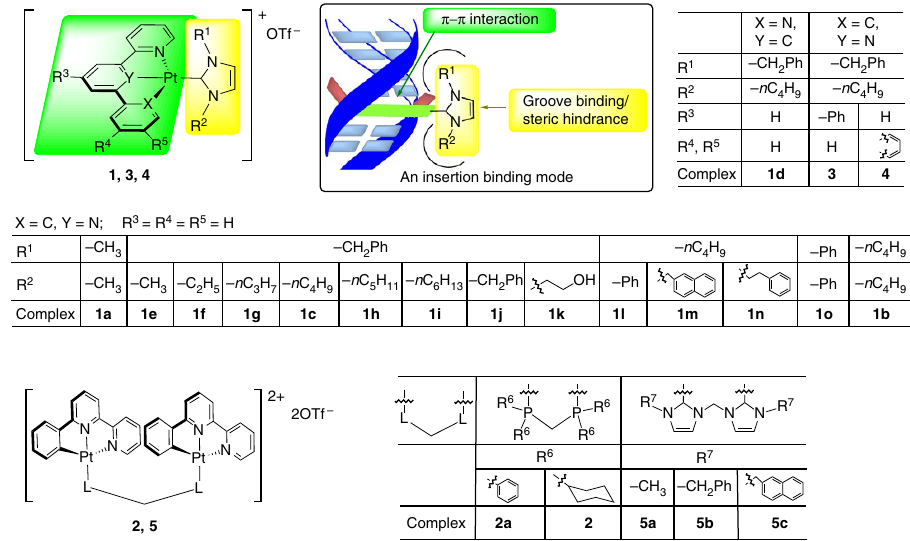
Figure 1 | Chemical structures and proposed binding modes. Platinum(II) complexes 1a – 1o , 2 , 2a , 3 , 4 and 5a – 5c . The counteranions for all complexes are CF 3 SO 3 (cid:2) . The inset shows the molecular design of Pt(II) complexes tested for binding mismatched